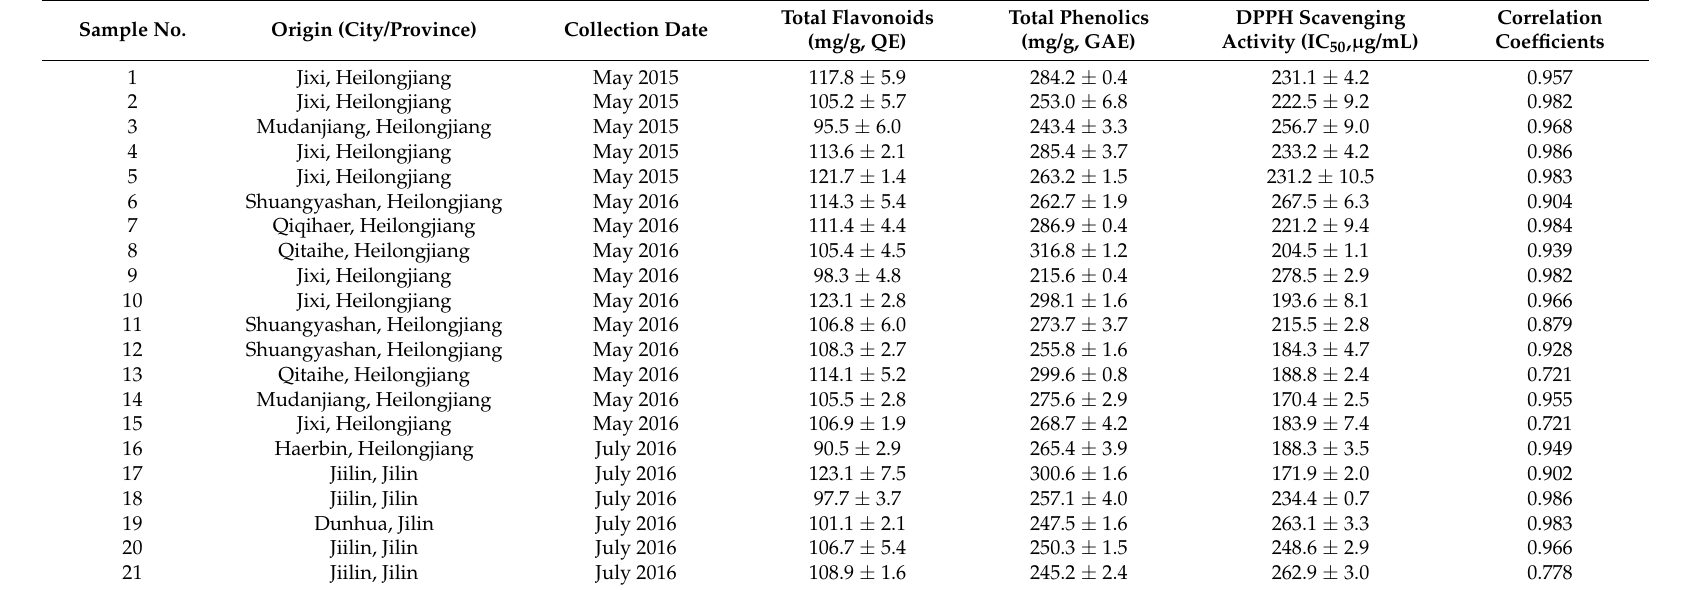
Table 1. Total phenolic, total flavonoid, antioxidant activity and correlation coefficients of CBM propolis. Note: Data are shown as the mean ± SD ( n = 3). GAE, gallic acid equivalent; QE, quercetin equivalent. Sample